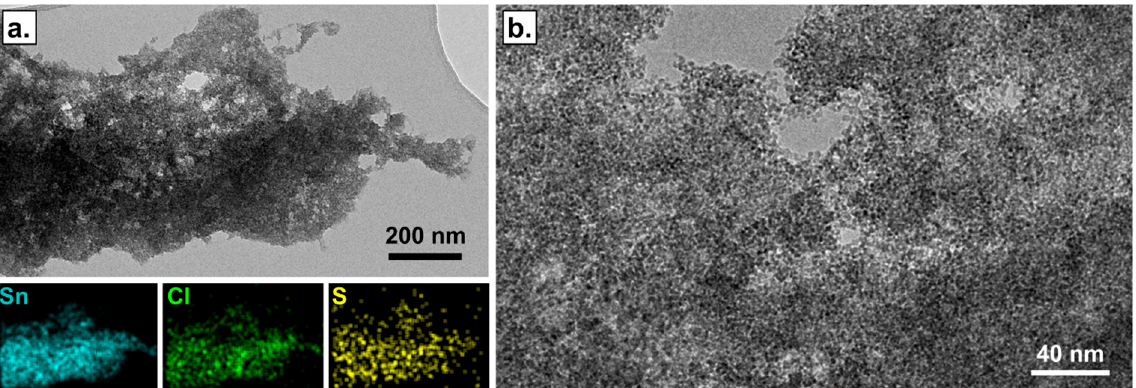
Figure 3. TEM images of PAni-SnCl 2 composite containing 3 wt% of PEDOT:PSS observed at different scales before any contact with hydrogen sulphide ( a ) and ( b ). The elementary chemical mapping from TEM image ( a ) show a good dispersion of tin (Sn, blue) and chlorine (Cl, green) atoms and of sulphur (S, yellow) atoms carried only by PEDOT and PSS molecules.